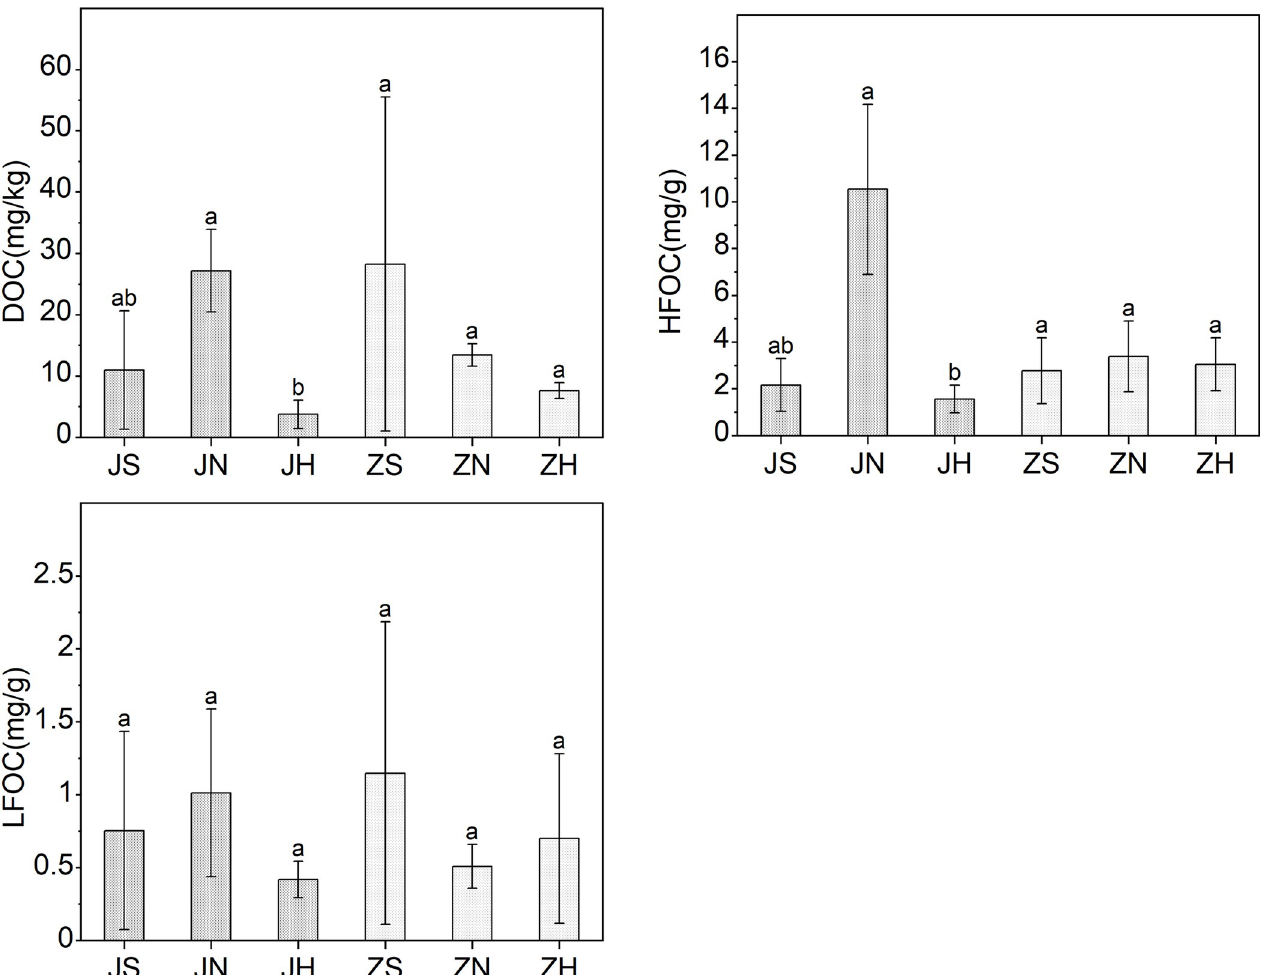
Fig 4. SOC comparison between different habitats in JWP and ZWP. JWP: Shili Lake Ecological Wetland Park; ZWP: Shandong Zoucheng Taiping National Wetland Park; JS, JN and JH are the wetland, farmland and lakeside grassland in JWP, respectively. ZS, ZN and ZH are the wetland, farmland and lakeside grassland in ZWP, respectively. DOC: dissolved organic carbon; LFOC: light fraction organic carbon; HFOC: heavy fraction organic carbon. Error bars represent standard deviation of the mean (n = 5). Different lowercase letters indicate significant differences ( p < 0.05).